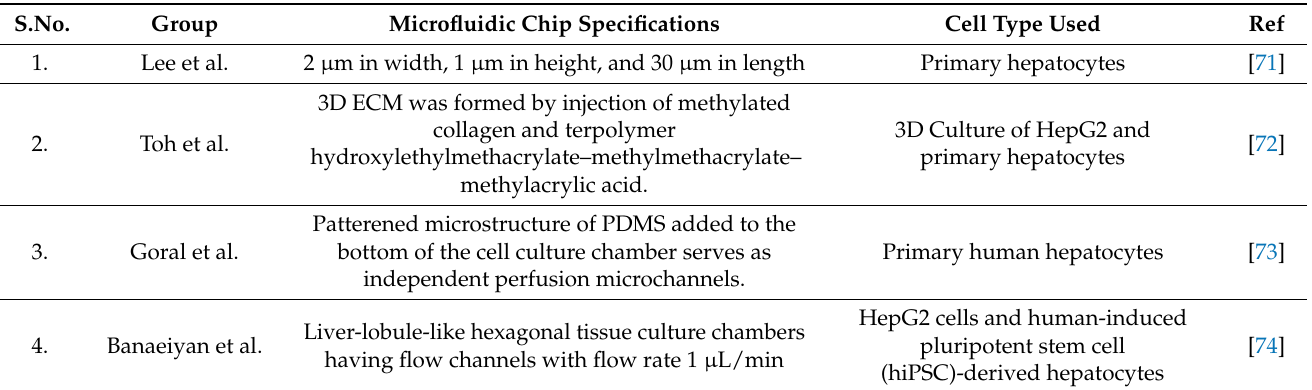
Table 2. List of studies that have used liver-on-chip configurations with shear stress for hepatocyte cultures. (ECM-Extracellular matrix;